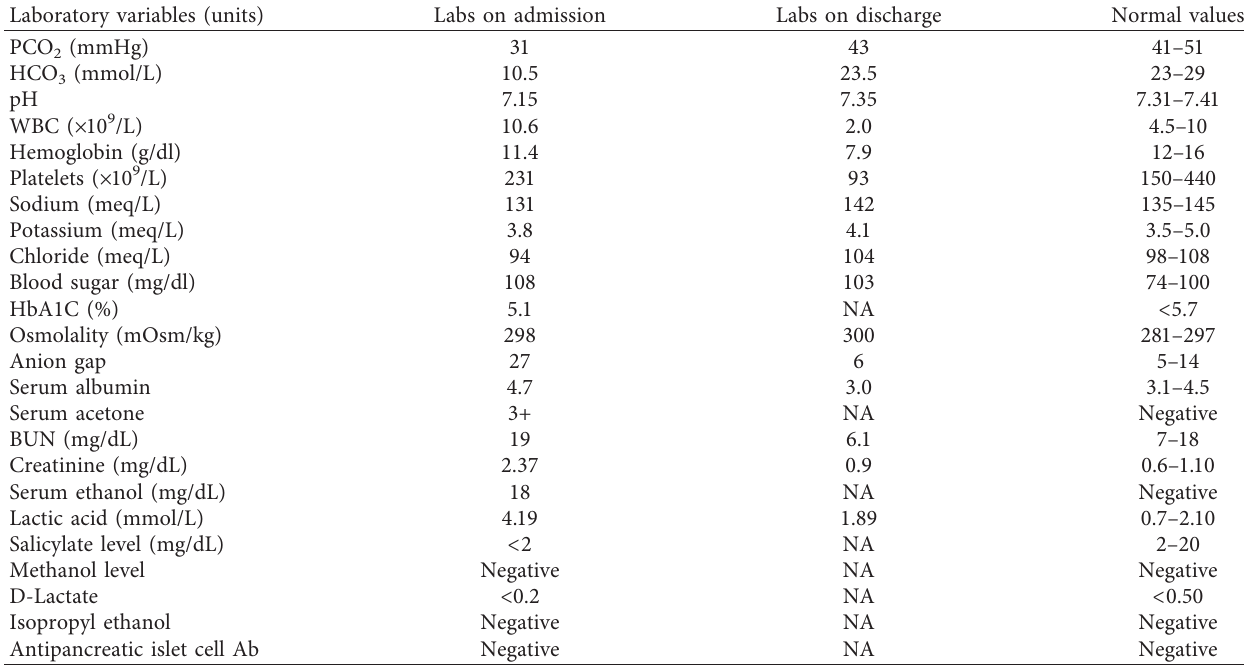
Table 1: Laboratory investigations at time of admission and